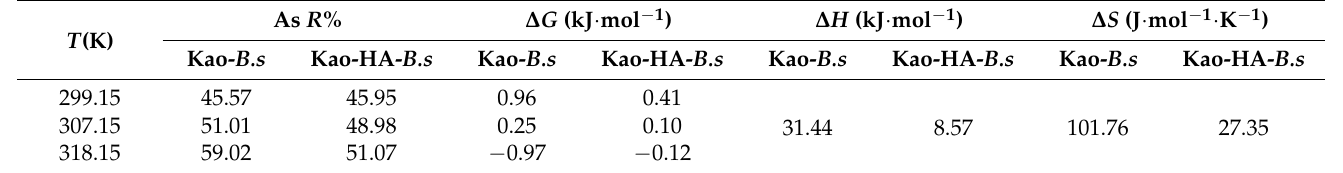
Table 3. Thermodynamic parameters of As(V) adsorption on Kao- B.s and Kao-HA- B.s